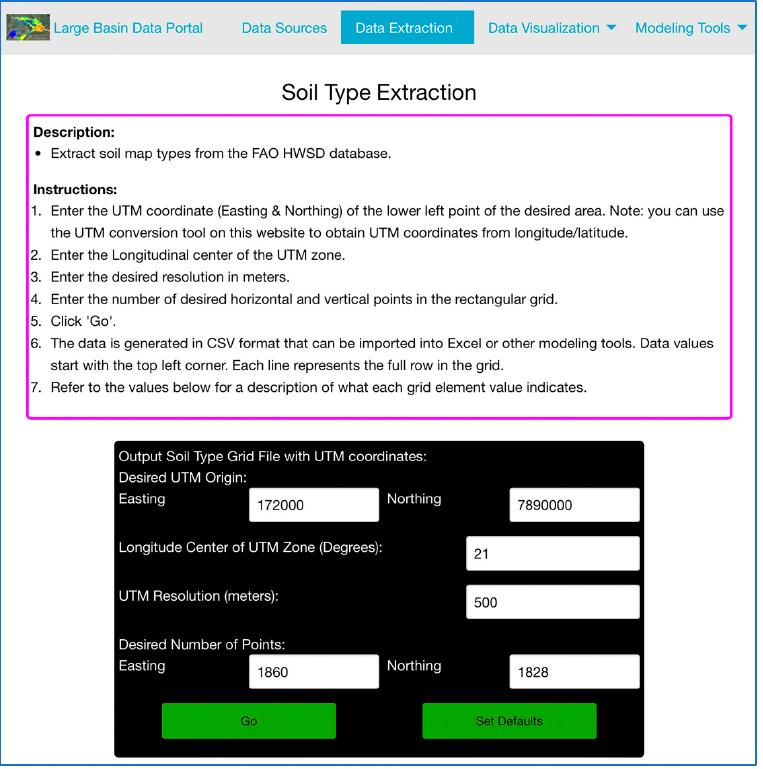
Figure 3. Screenshot of the Large Basin Data Portal soil type extraction tool with description, usage instructions, and input